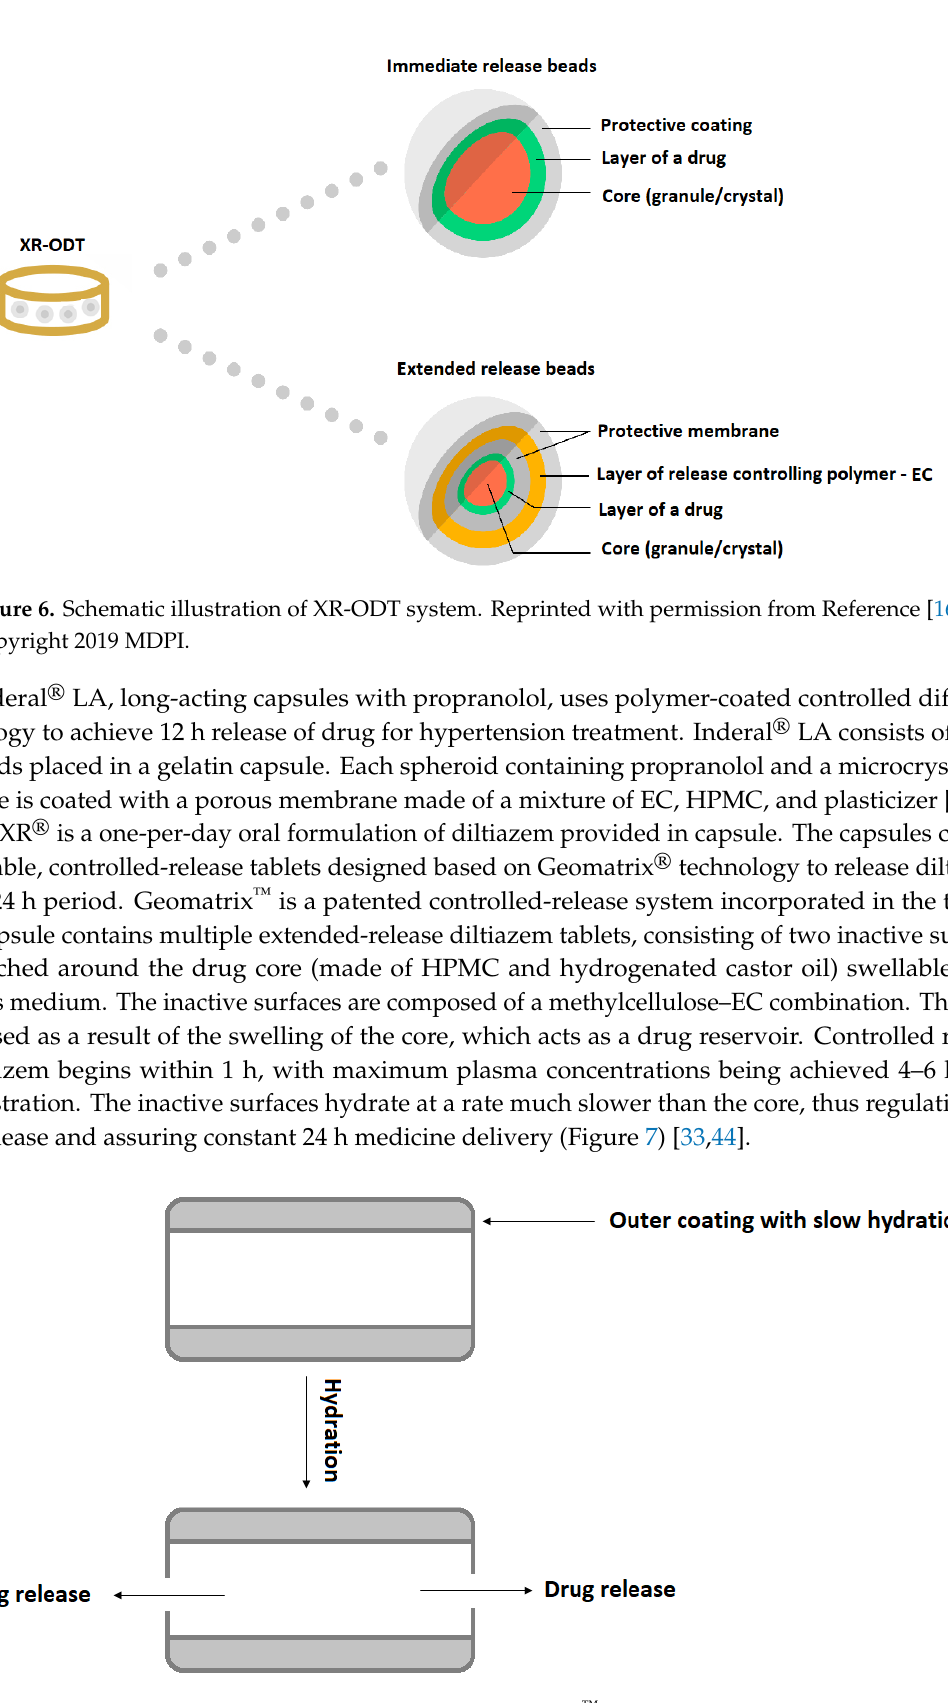
Figure 7. Schematic illustration of drug release from Geomatrix ™ system modified from Wan et al. [33].